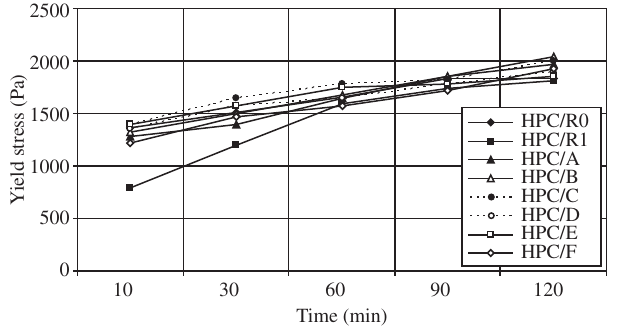
Figure 4. Curves of yield stress vs. time for evaluated